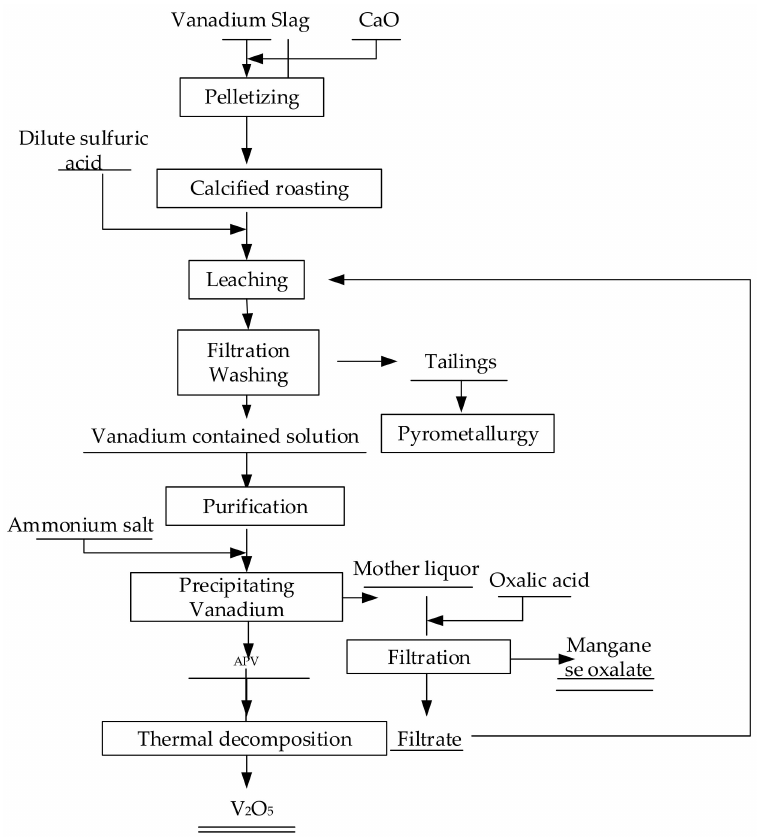
Figure 2. Flow chart for treating the converter vanadium